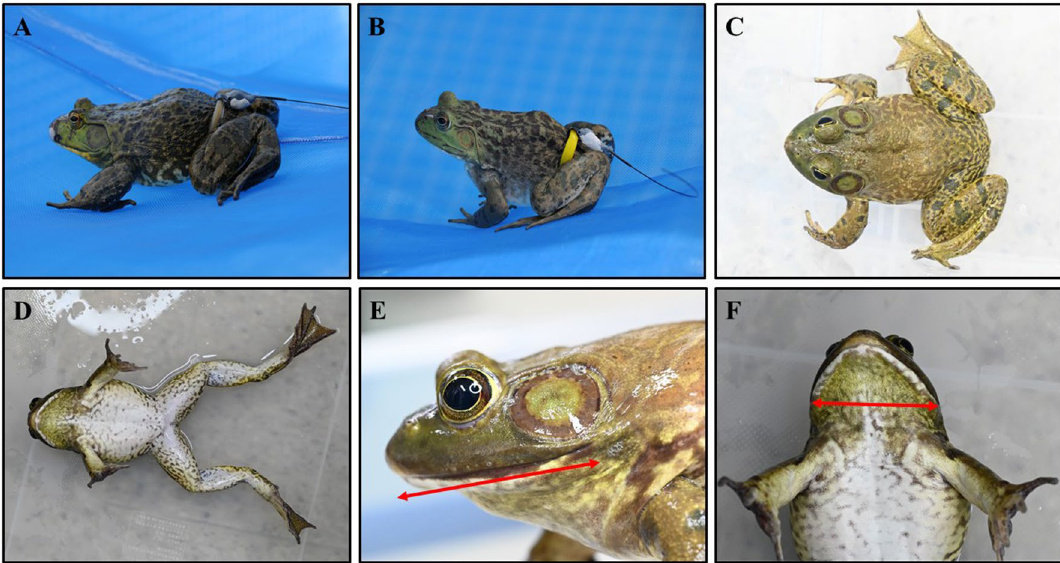
Figure 2. External features of Lithobates catesbeianus and the belt types used in radio-tracking- ( A ) dorsolateral view of a bullfrog with a latex belt, ( B ) dorsolateral view of a bullfrog with a stainless belt, ( C ) dorsal view, ( D ) ventral view, ( E ) mouth length, and ( F ) mouth